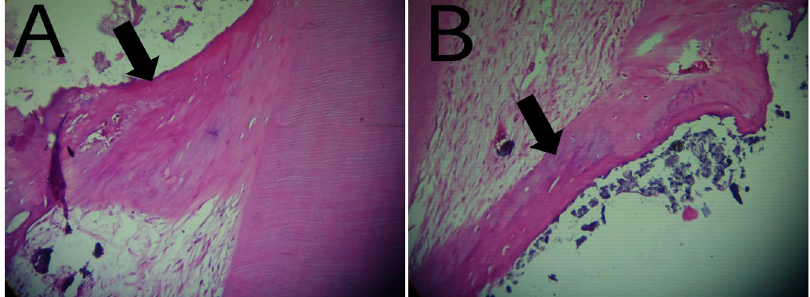
Fig. 4 The arrow points to dentin bridge formation. A Photomicrograph of dental pulp capped with Portland Cement. B Photomicrograph of dental pulp capped with